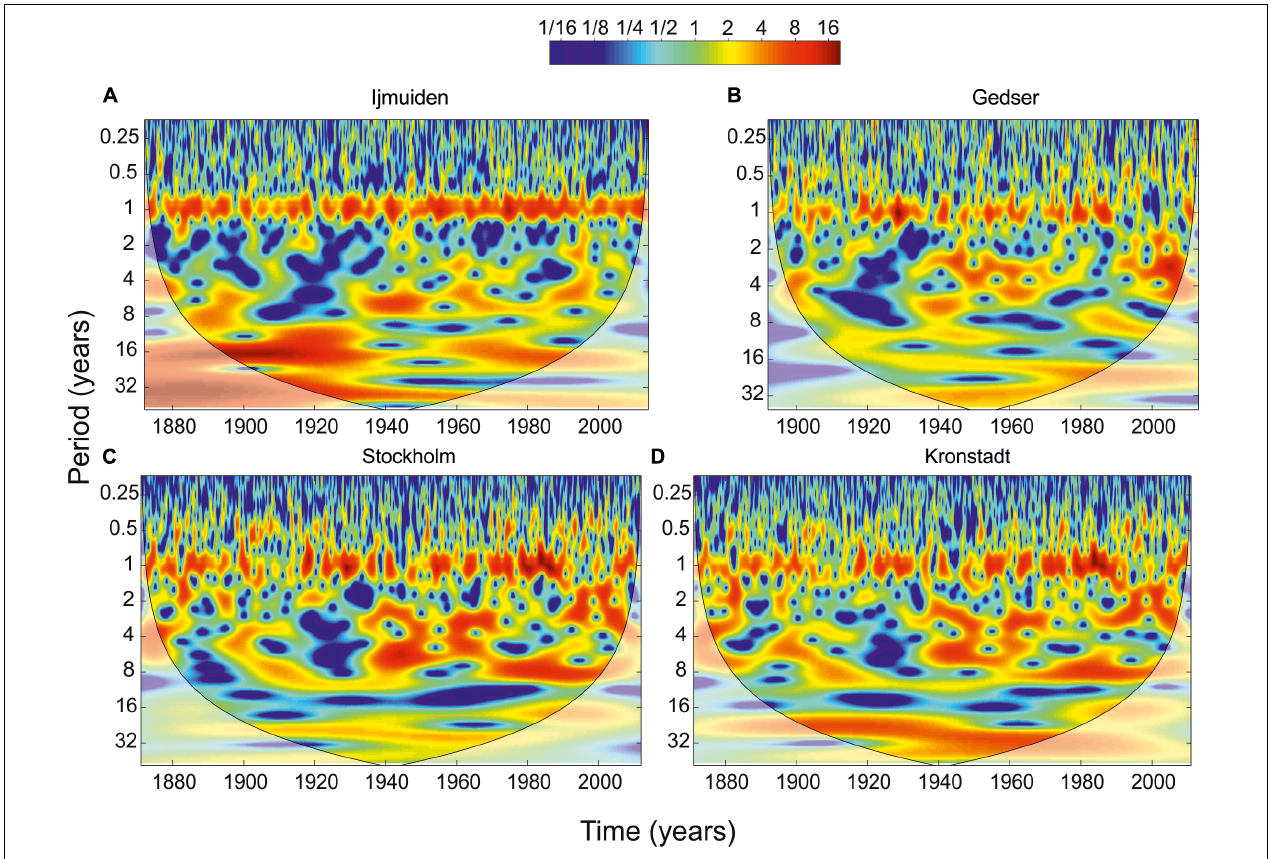
FIGURE 3 | Wavelet power spectrum (Morlet) of the MSL for the (A) IJmuiden (NS), (B) Gedser (DS), (C) Stockholm, and (D) Kronstadt (BS). The contours are in variance units. The color bar represents normalized variances. In all panels, the black thin line is the cone of influence where edge effects might distort the picture, shown in a lighter